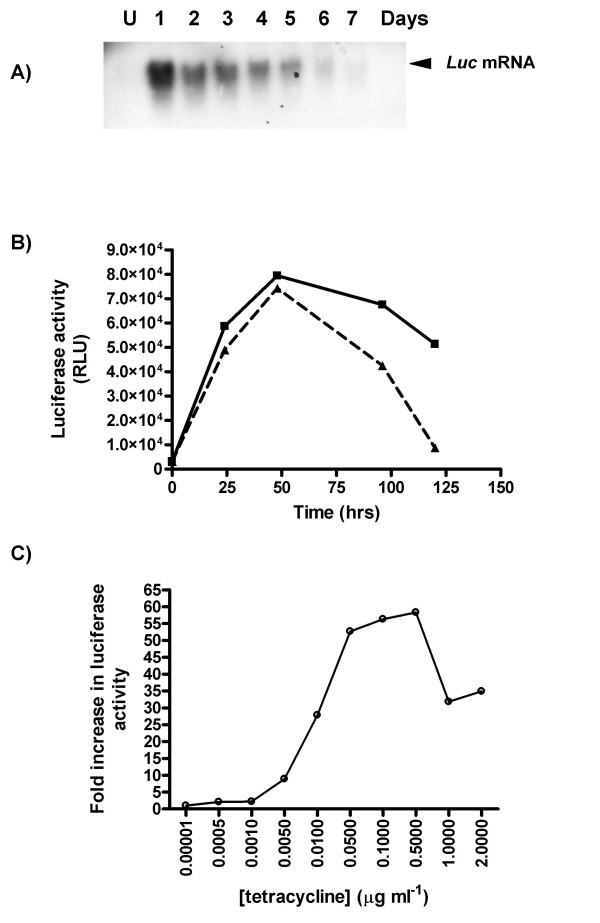
Induction of luciferase by tetracycline. (A) Expression of luciferase mRNA in a polyclonal line of tetracycline treated cells. pTcINDEX-Luc transformed epimastigotes were harvested each day following the addition of tetracycline to the cultures (5 μg ml-1). Lane U is the uninduced cell line. Lanes 1–7 represent days following induction. 1.25 μg total RNA was loaded in each lane. The blot was hybridised with a 1.7 kb Bam HI/Sal I fragment containing the luciferase ORF. (B) Luciferase activity over a time course. Cells were induced and aliquots removed for enzyme assay at indicated timepoints. Dashed line: cells were induced for 24 hours then washed twice in tetracycline-free medium and resuspended in tetracycline-free medium. Solid line: cells were induced with tetracycline then incubated with no further treatment. (C) Effect of tetracycline concentration on the level of luciferase activity. 10 identical flasks of epimastigotes (as above) were treated with different concentrations of tetracycline for 24 hours. Cells were harvested and the luciferase activity measured (Methods). The Y axis indicates the fold increase in luciferase activity above uninduced cells, normalised, to the amount of protein present in each extract.